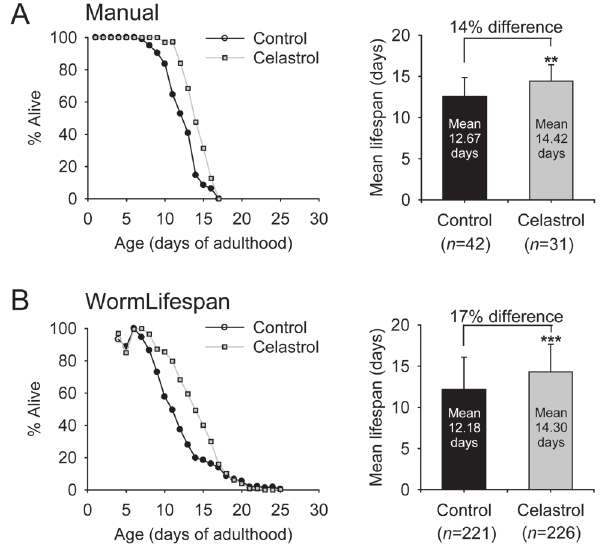
Figure 4. Celastrol increased lifespan. A lifespan assay was conducted using the manual method (A) or using the QuantWorm system (B). Worms were dosed every other day with 7 m mol/L agar celastrol or the solvent DMSO as a control. n represents the number of worms. ** p , 0.05; *** p , 0.001; p -value by log rank test.